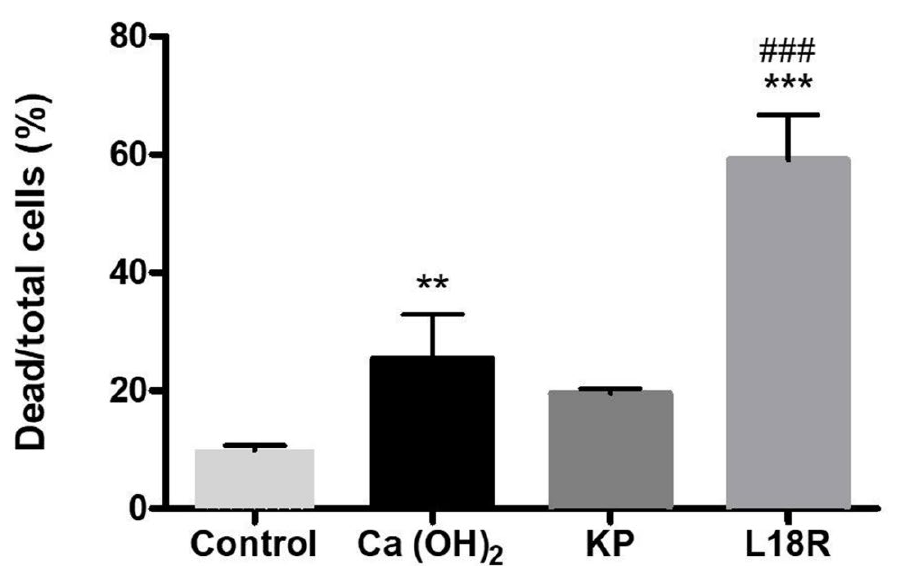
Figure 3. Dead cells (%) after treatment of E. faecalis biofilm pre-grown on HA disks. Values were obtained by 3D CLSM analysis of 48 h-old E. faecalis ATCC 29212 biofilms after exposure to H 2 O (control), Ca(OH) 2 -saturated solution, KP (100 µg/mL), and L18R (50 µg/mL) for 24 h. Red and green fluorescence intensity measures were carried out with Imaris 7.2 on four random fields of each disk. The results are expressed as means ± SD (**, p < 0.01 vs. control; ***, p < 0.001 vs. control; ###, p < 0.001 vs. Ca(OH) 2 ).